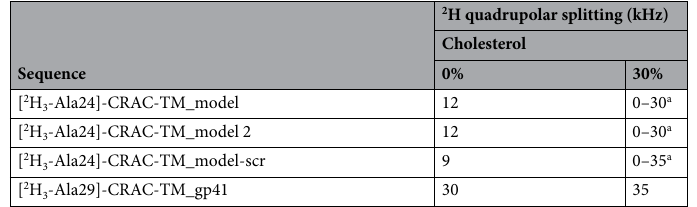
Table 4. 2 H quadrupolar splittings of [ 2 H 3 -Ala]-labelled CRAC-TM sequences where the isotopic label is within the transmembrane domain, reconstituted into POPC lipid bilayers that were uniaxially oriented with the normal parallel to the magnetic field direction at peptide-to-lipid ratios of 2 mol% in the presence or absence of 30 mol% cholesterol. a Indicates a broad signal covering a range of quadrupolar splittings.